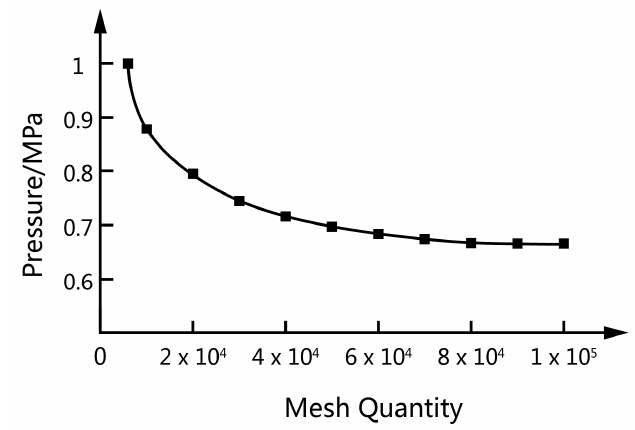
Figure 3. Mesh independence verification.